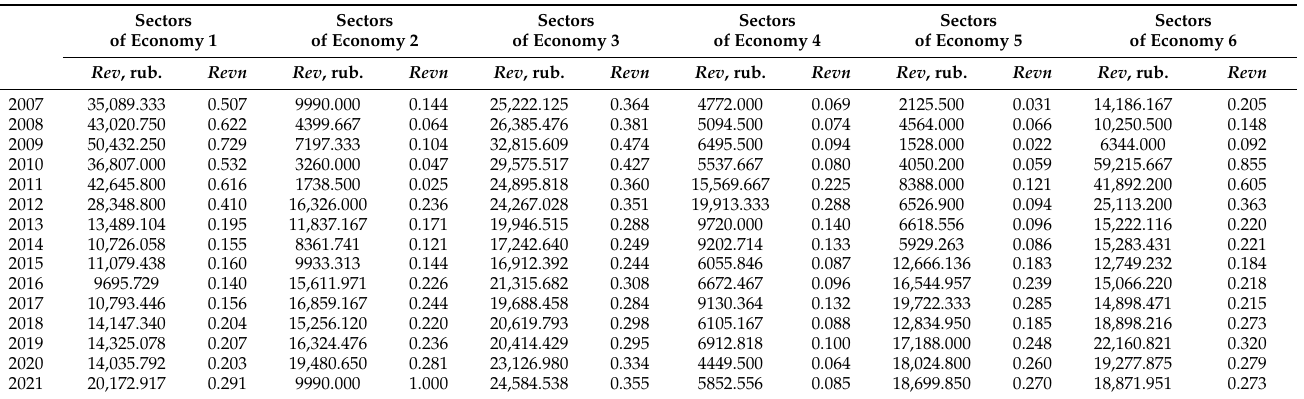
Table 4. Regression coefficients (author’s results).